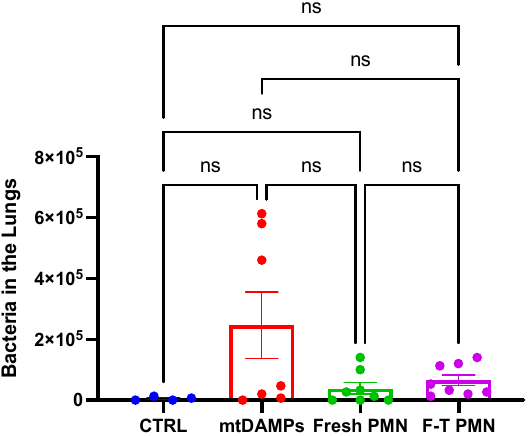
Figure 7. Freeze–thaw PMN induce bacterial killing in vivo. Similar to Figure 5, we applied freshly isolated and freeze–thaw human PMN to our mouse injury/lung bacterial infection model. Although there was no significant difference (ns), we could see a tendency that freeze–thaw PMN could be as effective as freshly isolated human PMN. The numbers of animals used for control (CTRL), mtDAMPs, mtDAMPs + fresh PMN (Fresh PMN), and mtDAMPs + freeze–thaw PMN (F-T PMN) were n = 4, n = 7, and n = 8, and n = 8, respectively. Mean and SE values are shown. There was no significant di ff erence by one-way ANOVA, Tukey.